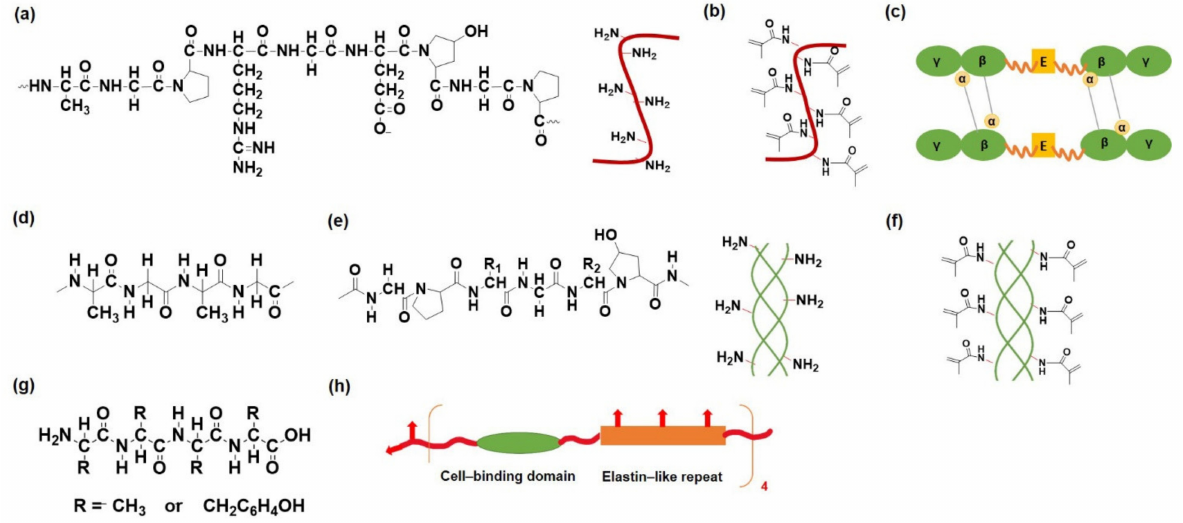
Figure 2. Chemical structure of protein/peptide–based polymers and their modifications ( a ) gelatin, ( b ) methacrylated gelatin (GelMA), ( c ) fibrin (protein structure), ( d ) silk fibroin (primary chemical structure and protein structure, ( e ) collagen, ( f ) methacrylated collagen, ( g ) silk-sericin, and ( h ) elastin-like